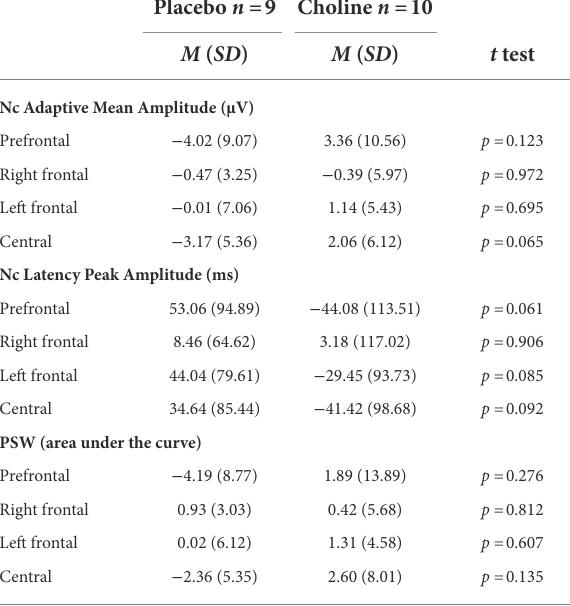
TABLE 2 Change in the ERP familiarity response (familiar-unfamiliar) from baseline to the 9-month follow-up as a function of